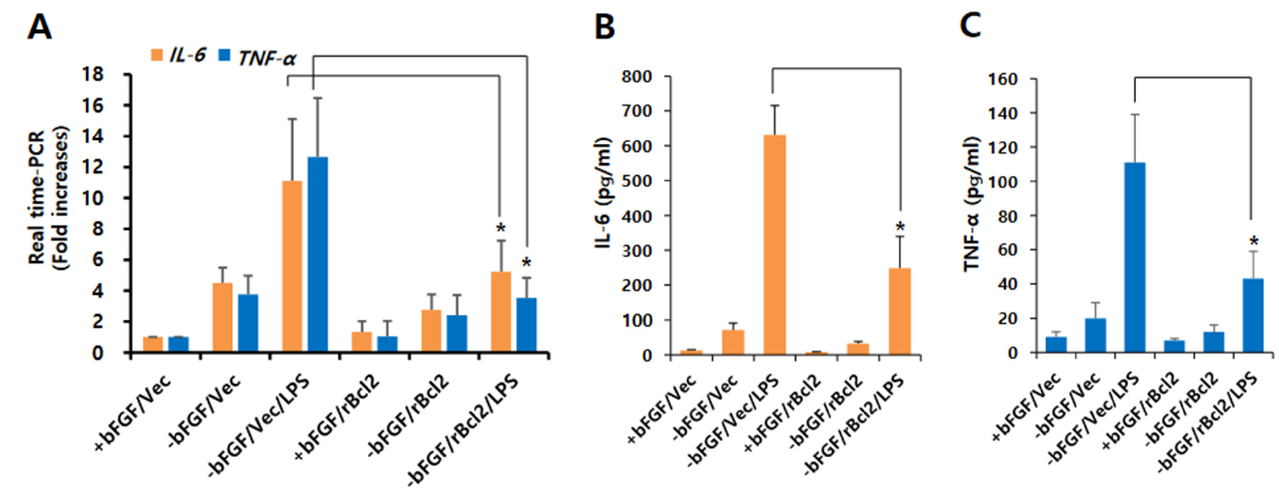
Figure 3. Effect of Bcl-2 overexpression on LPS-induced IL-6 and TNF- α production in NSCs. ( A ) MSCV-IRES-EGFP or rBcl-2 -MSCV-IRES-EGFP was transfected into the NSCs for 48 h, and the cells were treated with LPS (1 µ g/mL) for 12 h in the absence of bFGF. The mRNA levels of IL-6 and TNF- α were analyzed by real-time RT-PCR; n = 3. Data are shown as mean ± SD. * p < 0.05 compared with –bFGF/Vector/LPS control, for IL-6 and TNF- α respectively. ( B , C ) MSCV-IRES-EGFP or rBcl-2 -MSCV-IRES-EGFP was transfected into the NSCs for 48 h, and the cells were treated with LPS (1 µ g/mL) for 24 h in the absence of bFGF. The levels of IL-6 ( B ) and TNF- α ( C ) were measured by ELISA. Data are shown as means ± SD. * p < 0.05 compared with –bFGF/Vector/LPS control. Statistical significances were assessed by one-way ANOVA with a post hoc Tukey’s